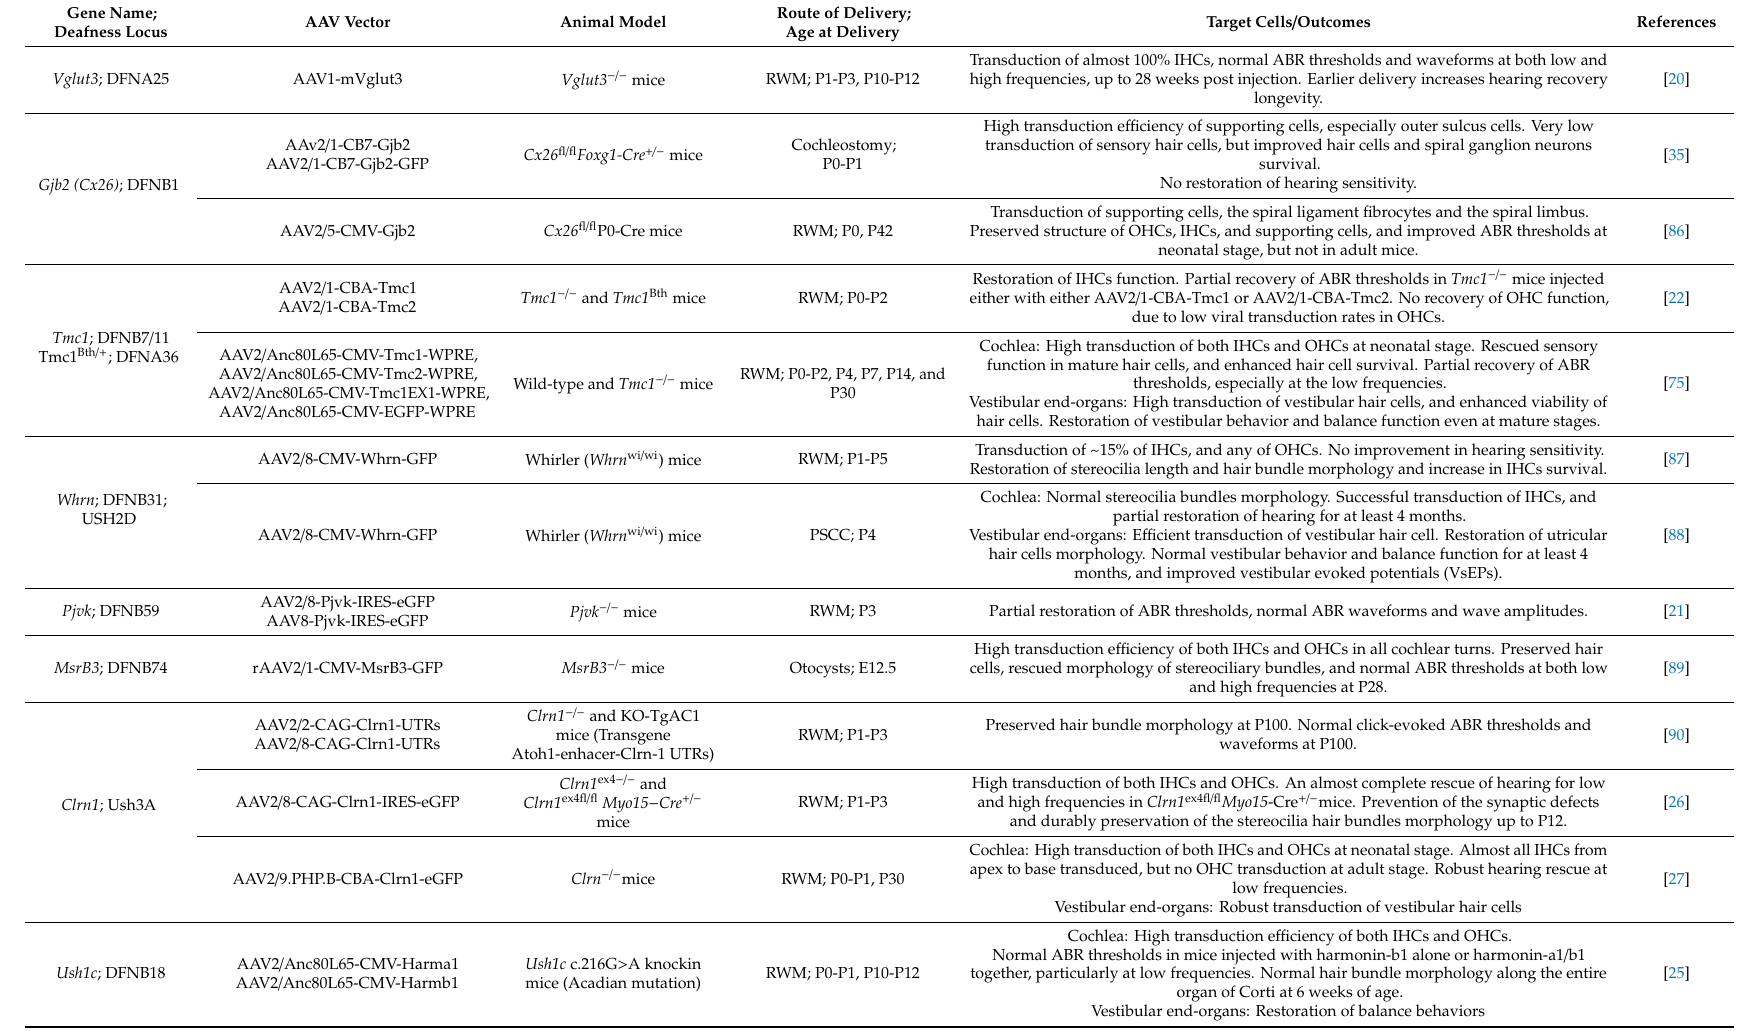
Table 1. A summary of adeno-associated virus (AAV) vectors used in gene therapy for genetic hearing impairments and vestibular